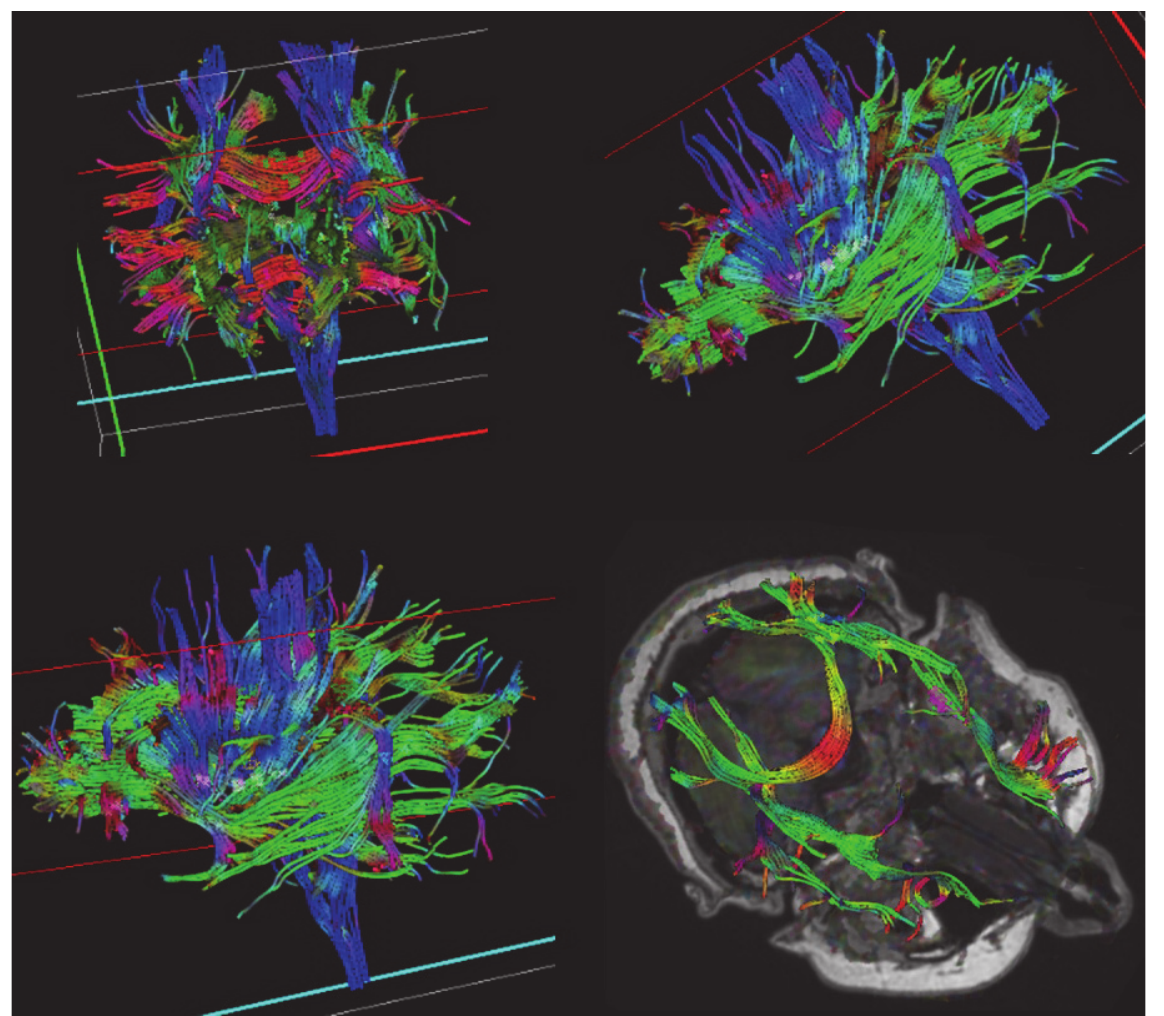
Figure 2: DTI images showing a slight reduction in anisotropy and diminished color brightness at the affected region with a normal organization of the fiber